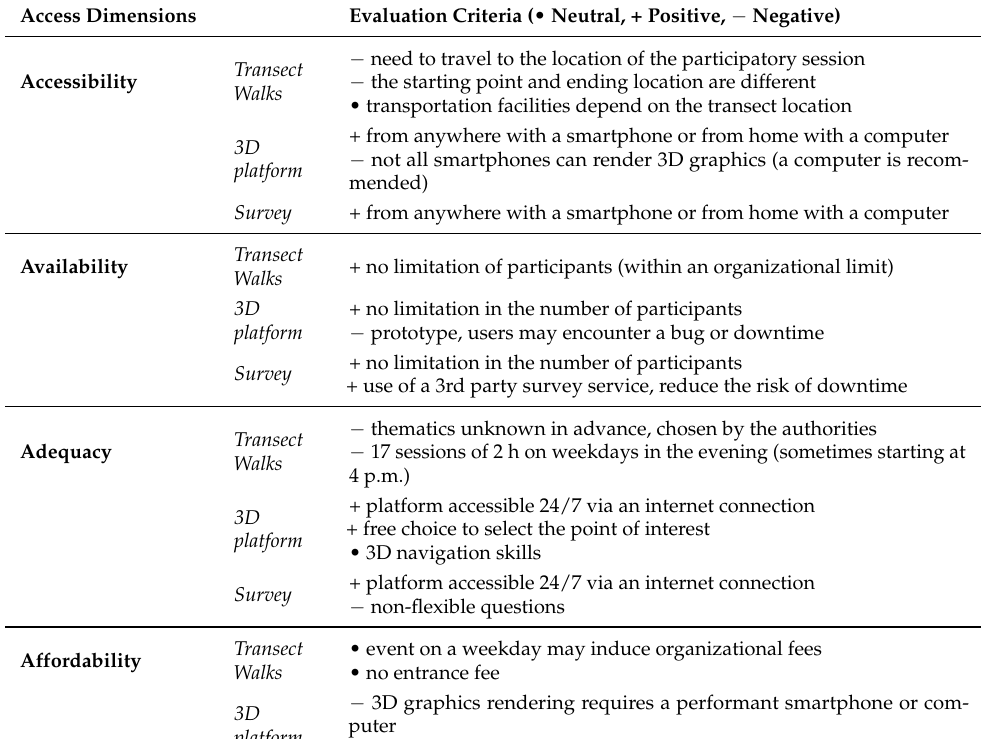
Table 3. Side-by-side comparison of medium alternatives facing access dimensions, argumentative